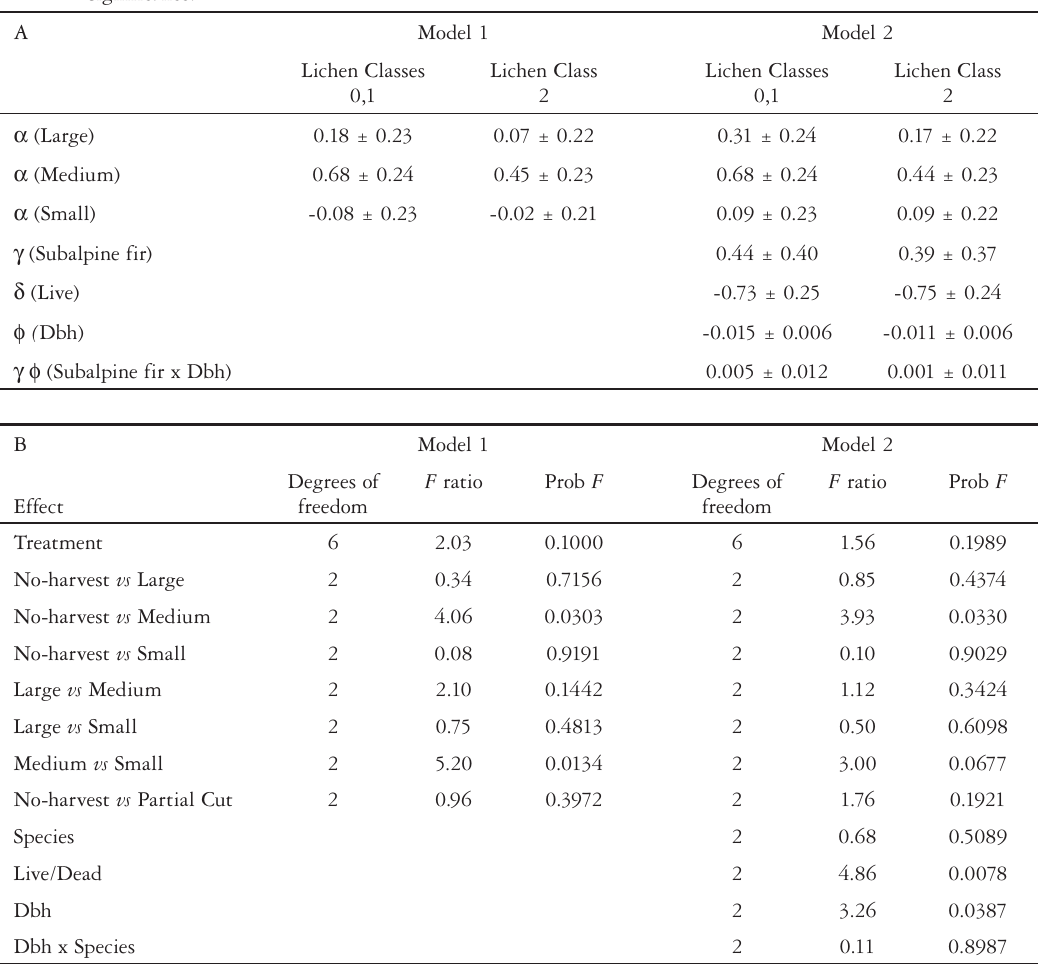
Table 1. Logistic regression models of lichen abundance distribution immediately post-harvest (1993). The reference value in the analysis is Lichen Classes 3, 4. A) Parameter estimates ( ± estimated standard error). B) Tests of